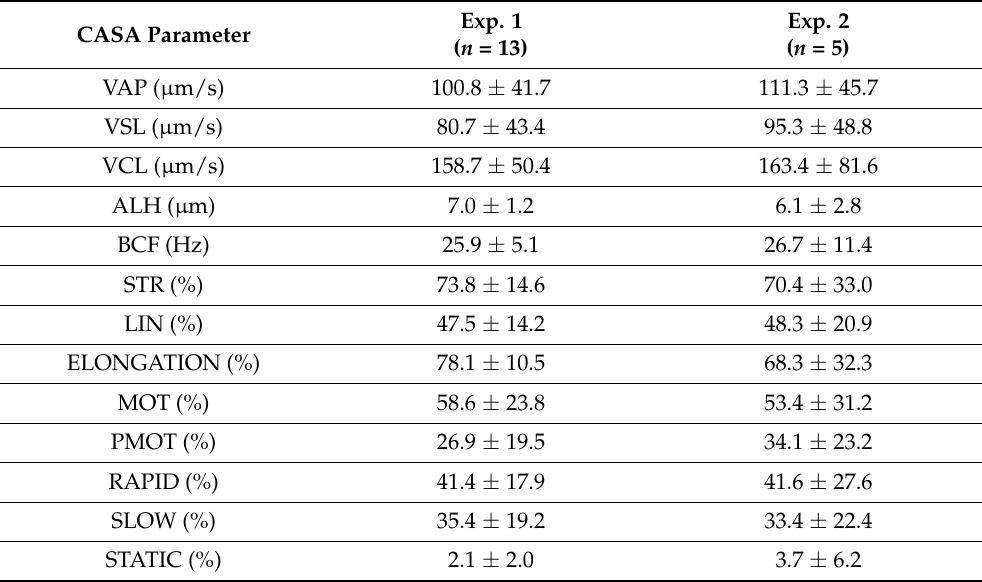
Table 1. Sperm motility parameters obtained by CASA of semen used in Exp. 1 and Exp. 2. Results presented as mean ± SD.